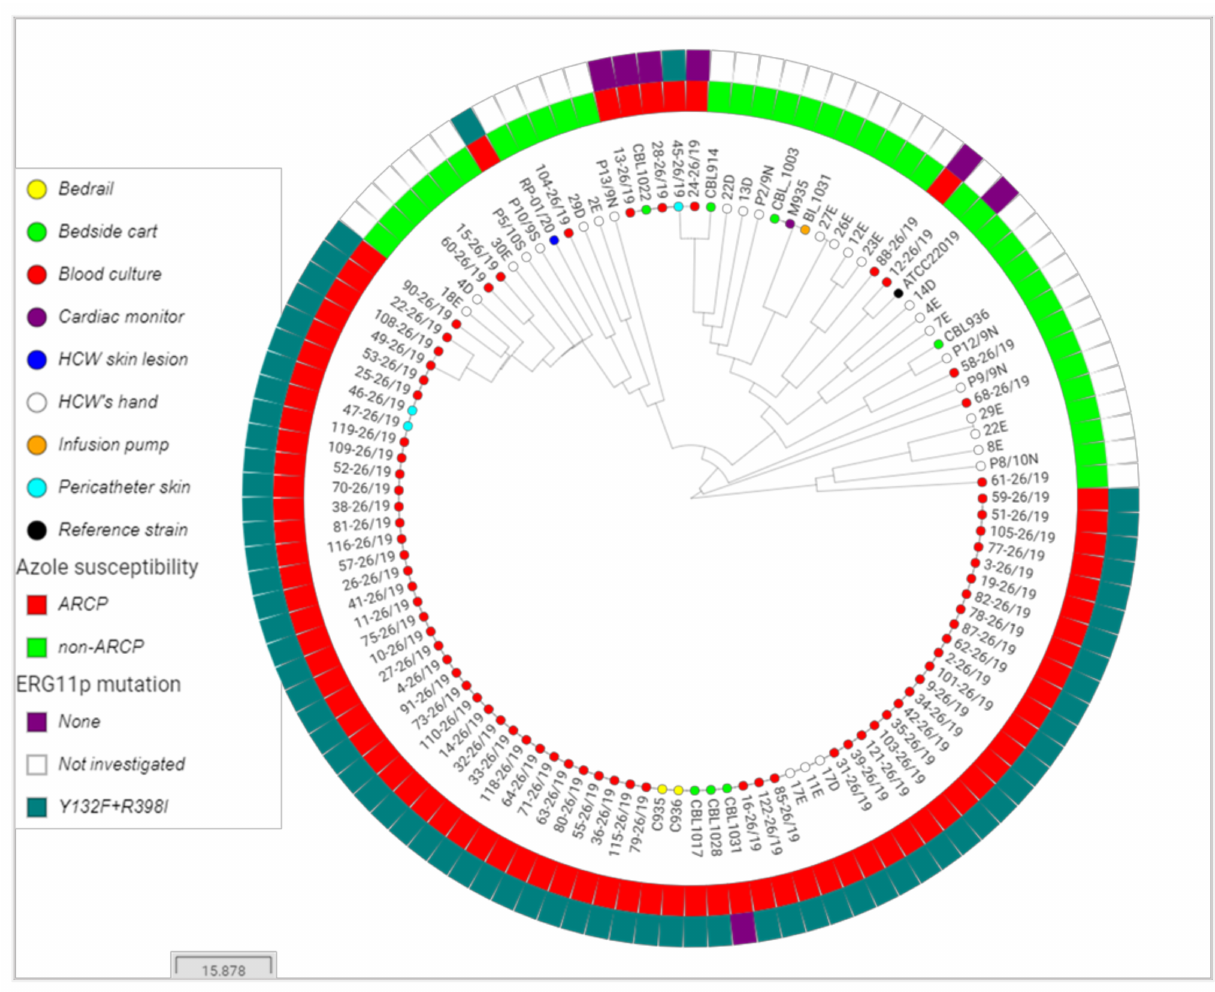
Figure 3. Circular tree generated from 112 C. parapsilosis sensu stricto isolates obtained from the adult oncology intensive care unit in 2019. The small colored circles indicate the isolate source. ARCP = azole-resistant C. parapsilosis . Candida parapsilosis isolates per 100 positive blood cultures at the end of 2018 increased 254% compared to the end of 2017 (Figure 1). Successively, ninety episodes of C. parapsilosis sensu stricto candidemia were detected from January 2019 to April 2020 and 88% were caused by ARCP isolates (Figure 2). These isolates were associated with higher crude mortality rate at 30 days (63.8%) than non-ARCP ones (20%, p = 0.008). The Kaplan–Meier curve highlighted that patients infected with ARCP isolates had a significantly higher mortality rate than those with non-ARCP ( p = 0.025, Figure